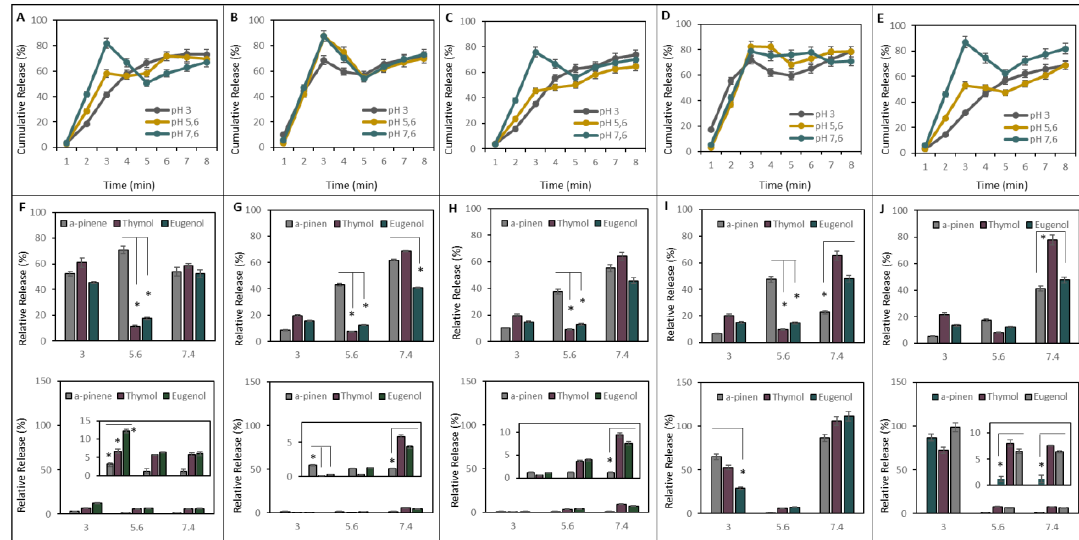
Figure 2. The release study: All types of NCaps and (0.1%) EOs were tested in pH 3, 5.6 and 7.6 during 8-h incubation under 37 °C. The cumulative release of ( A ) C, ( B ) C-A, ( C ) C-G, ( D ) C-X and ( E ) C-P ( F ) C, ( G ) C-A, ( H ) C-G, ( I ) C-X and ( J ) C-P NCaps after 1 h is shown on the top and after 8 h is shown